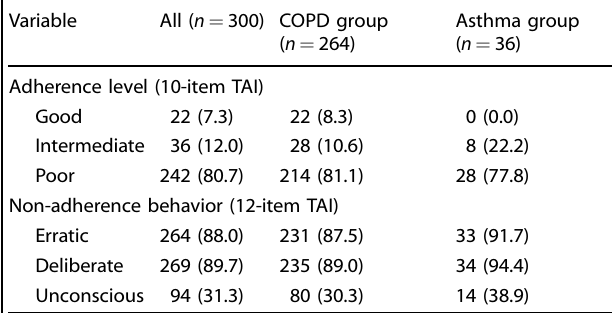
Table 2. Availability of respiratory medication and inhaler technique Table 3. Adherence to inhalers, adherence level and non-adherence behavior patterns in asthma and/or COPD